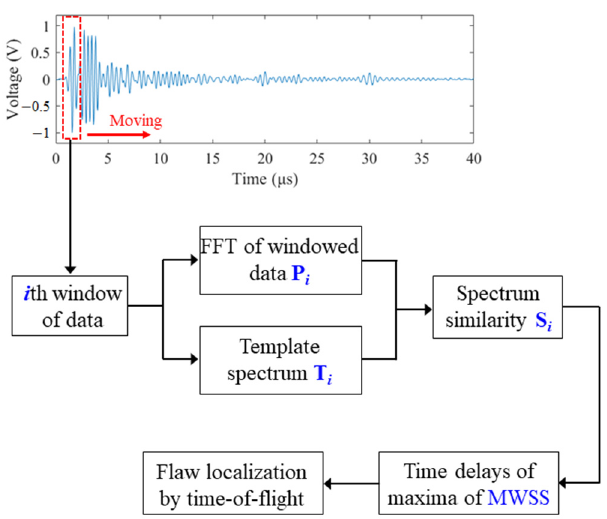
Figure 1. The proposed flaw-detection scheme.